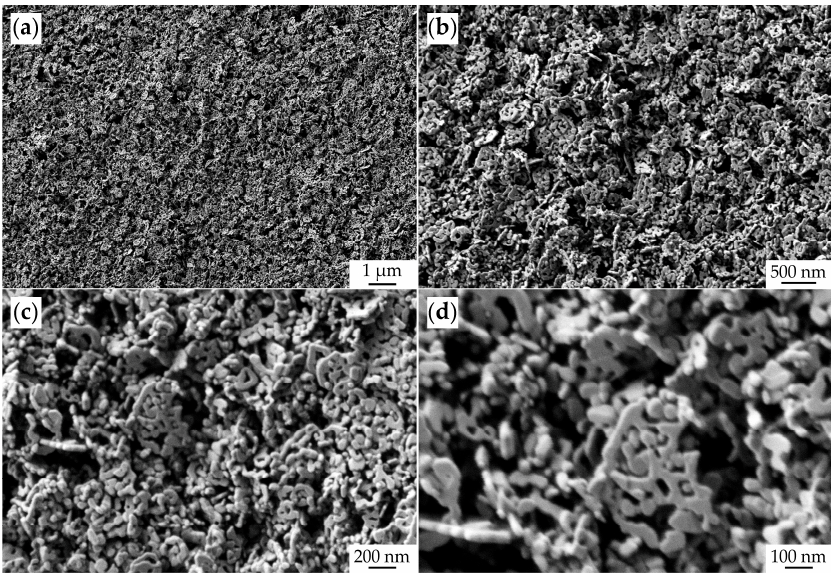
Figure 7. Microstructure of the printed Co 3 O 4 film (according to SEM data; ×20 k ( a ), ×50 k ( b ), ×100 k ( c ), ×200 k ( d )).